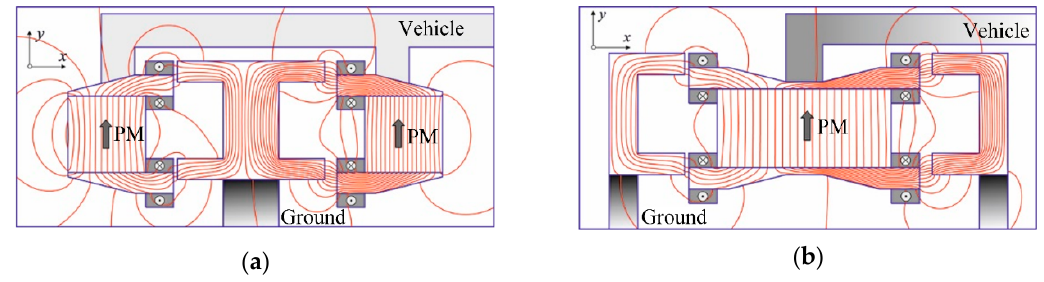
Figure 1. ( a ) Levitation systems with controlled permanent magnets; ( b ) Unbalanced position with current compensation.